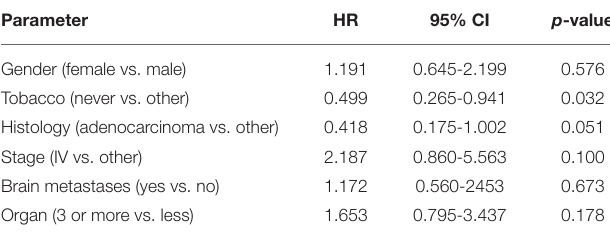
TABLE 3 | Cox multivariate analysis on OS.